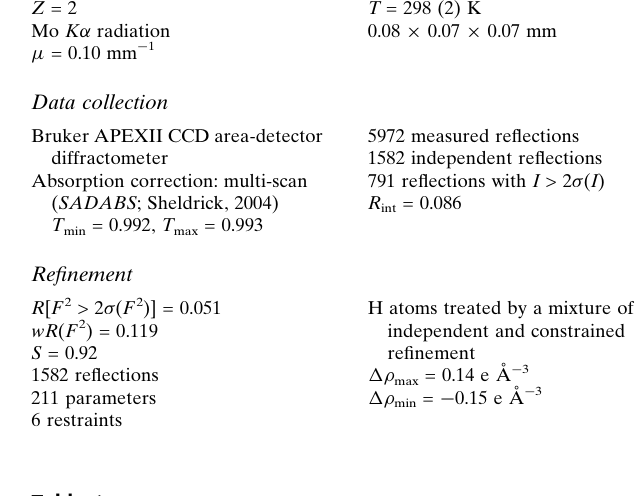
Hydrogen-bond geometry (A˚ , (cid:2)